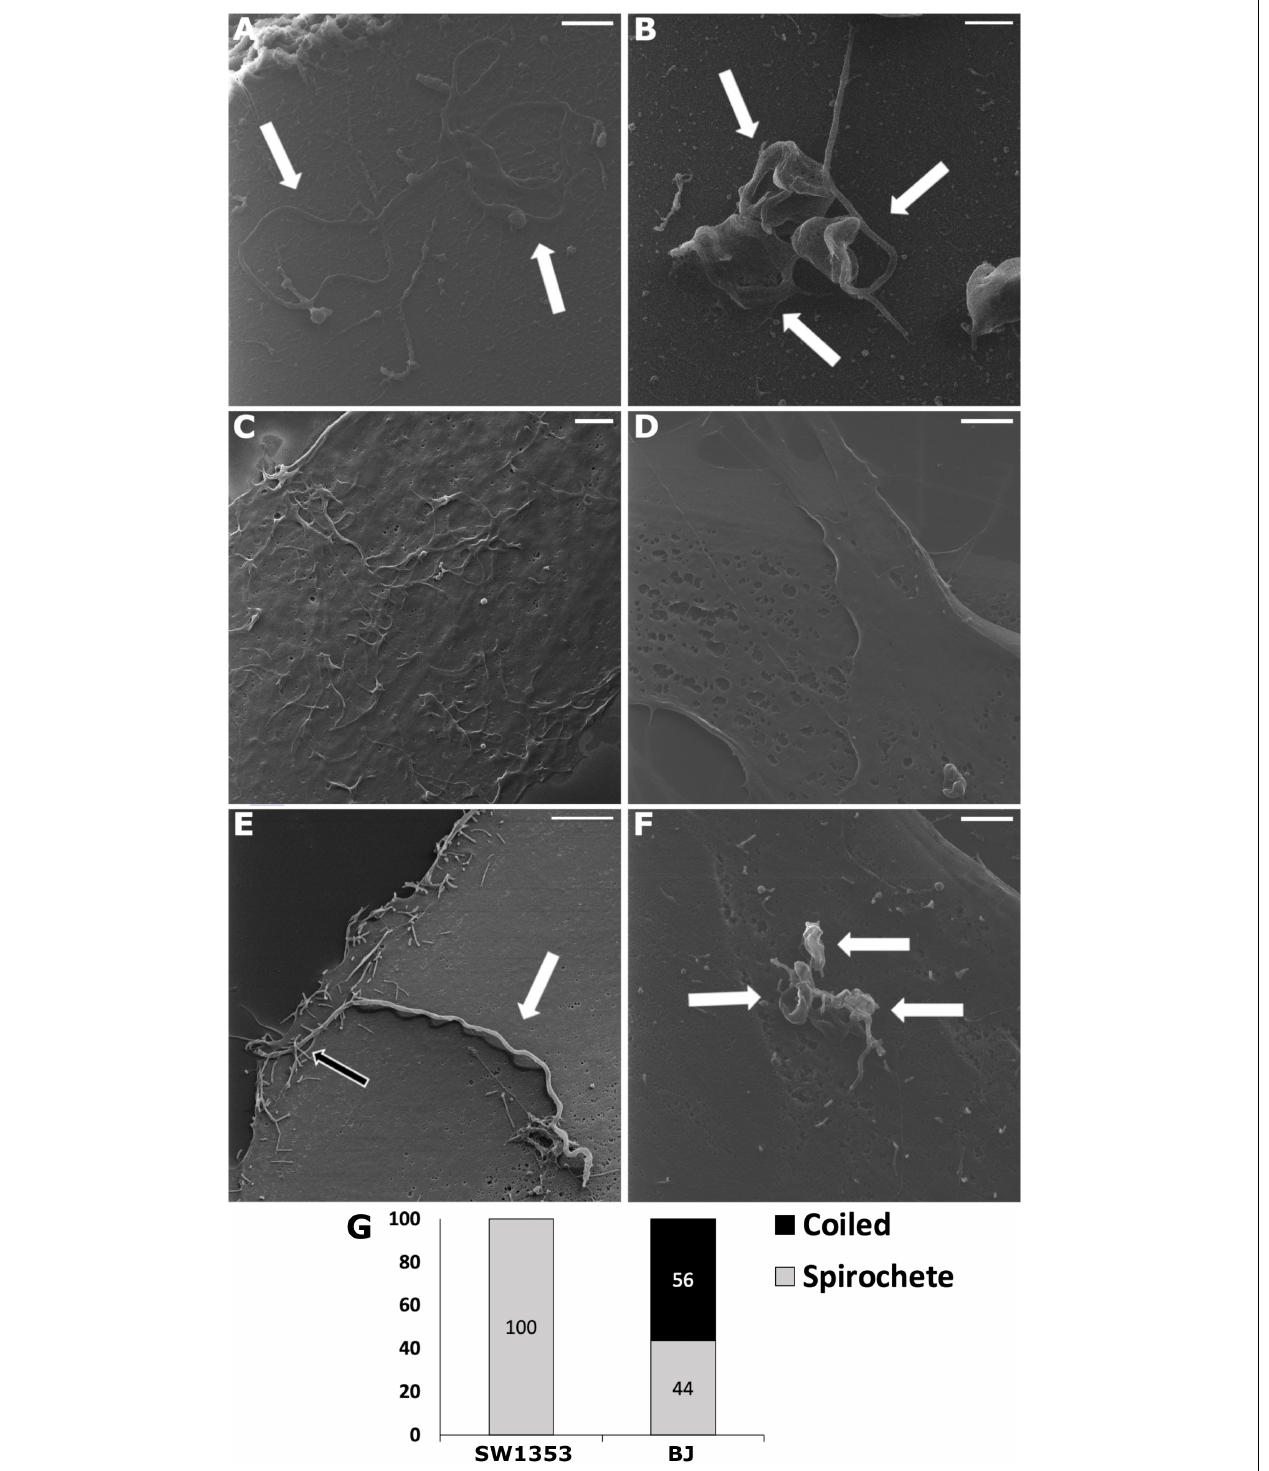
FIGURE 1 | Upon infection, human cell lines demonstrated Borrelia burgdorferi forms differently. Helium ion microscopy (Zeiss Orion Nanofab) images of Borrelia spirochetes (A) and round bodies (B) , as well as, uninfected chondrosarcoma (SW1353) (C) and dermal fibroblast (BJ) (D) cells. (E,F) Borrelia spirochetes and coiled forms invaded SW1353 and BJ cells, respectively, at 30 min post-infection. (G) A total of 20 infected human cells were counted and the different B. burgdorferi forms were analyzed. Graph presents spirochete and coiled forms attached to SW1353 and BJ cells in percentages. White arrows indicating Borrelia , while the black arrow points to cellular interactions with the bacterium. Scale bars (A–C) : 1 µ m, (D–F) : 2 µ m. Representative images from two separate experiments.